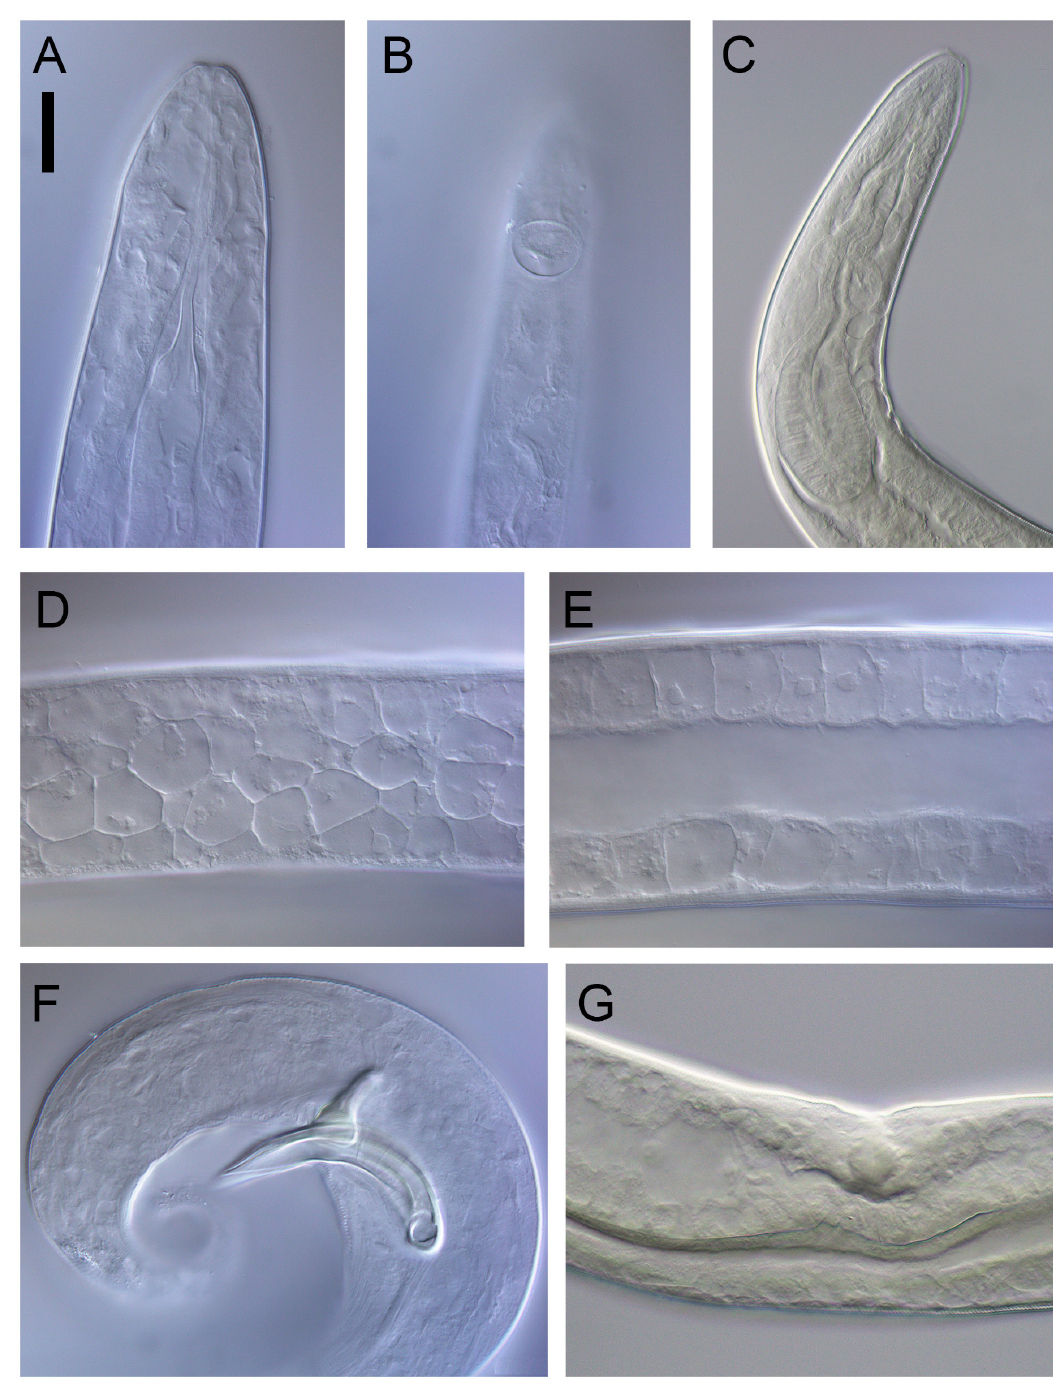
Fig. 3. Siphonolaimus curtisensillus sp. nov. Light micrographs. A – B , F . Holotype (NIWA154903). C . Paratype (NIWA154905). D – E , G . Paratype (NIWA154904). A . Male cephalic region showing pharynx and stylet. B . Male cephalic region showing amphid. C . Female anterior body region. D – E . Male intestine. F . Copulatory apparatus. G . Vulva and proximal portion of female genital branch. Scale bar: A–B = 20 µm; C–F = 10 µm; G = 15